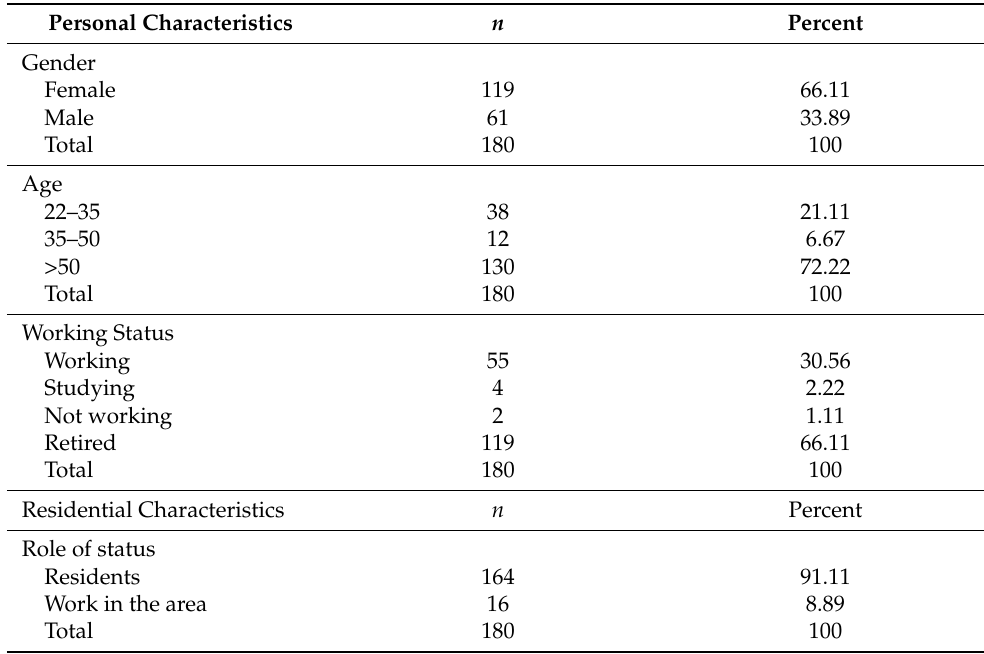
Table 2. Frequencies for categorical demographic